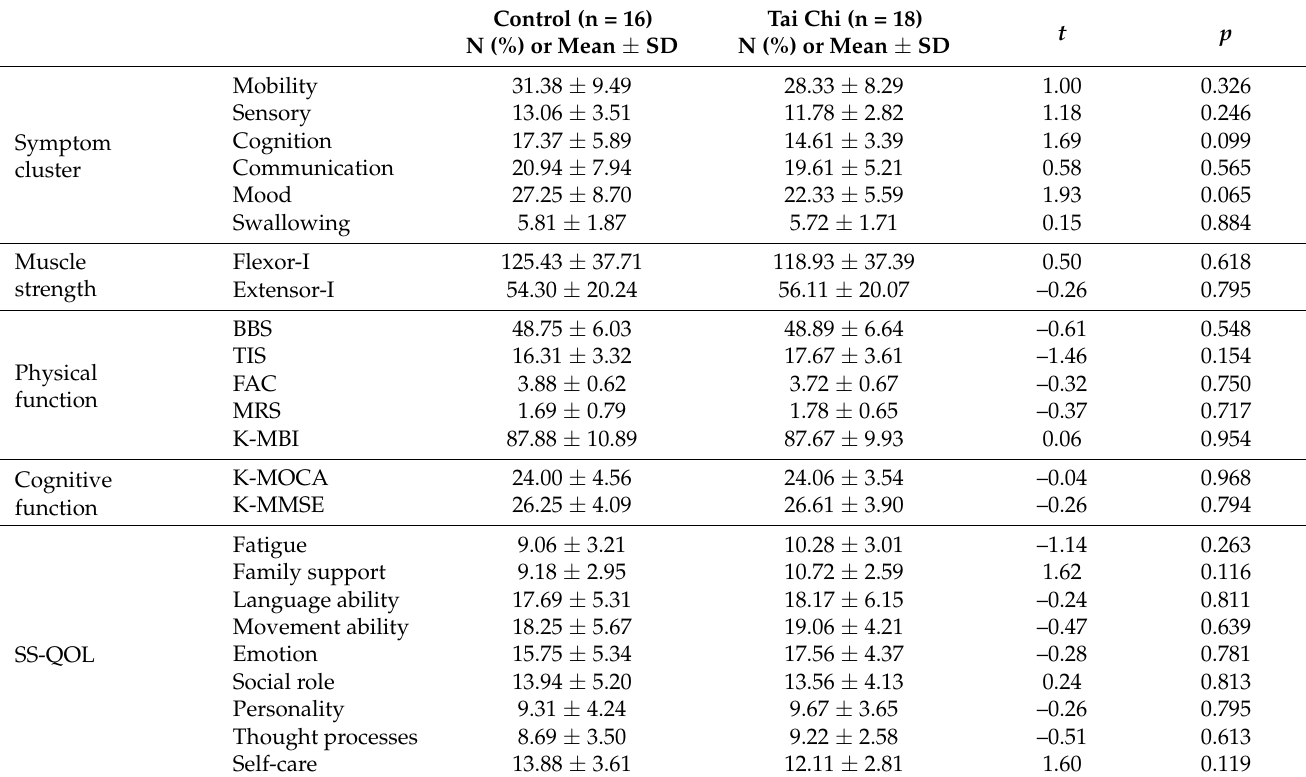
Table 2. Results from homogeneity tests of the study variables at baseline ( N =